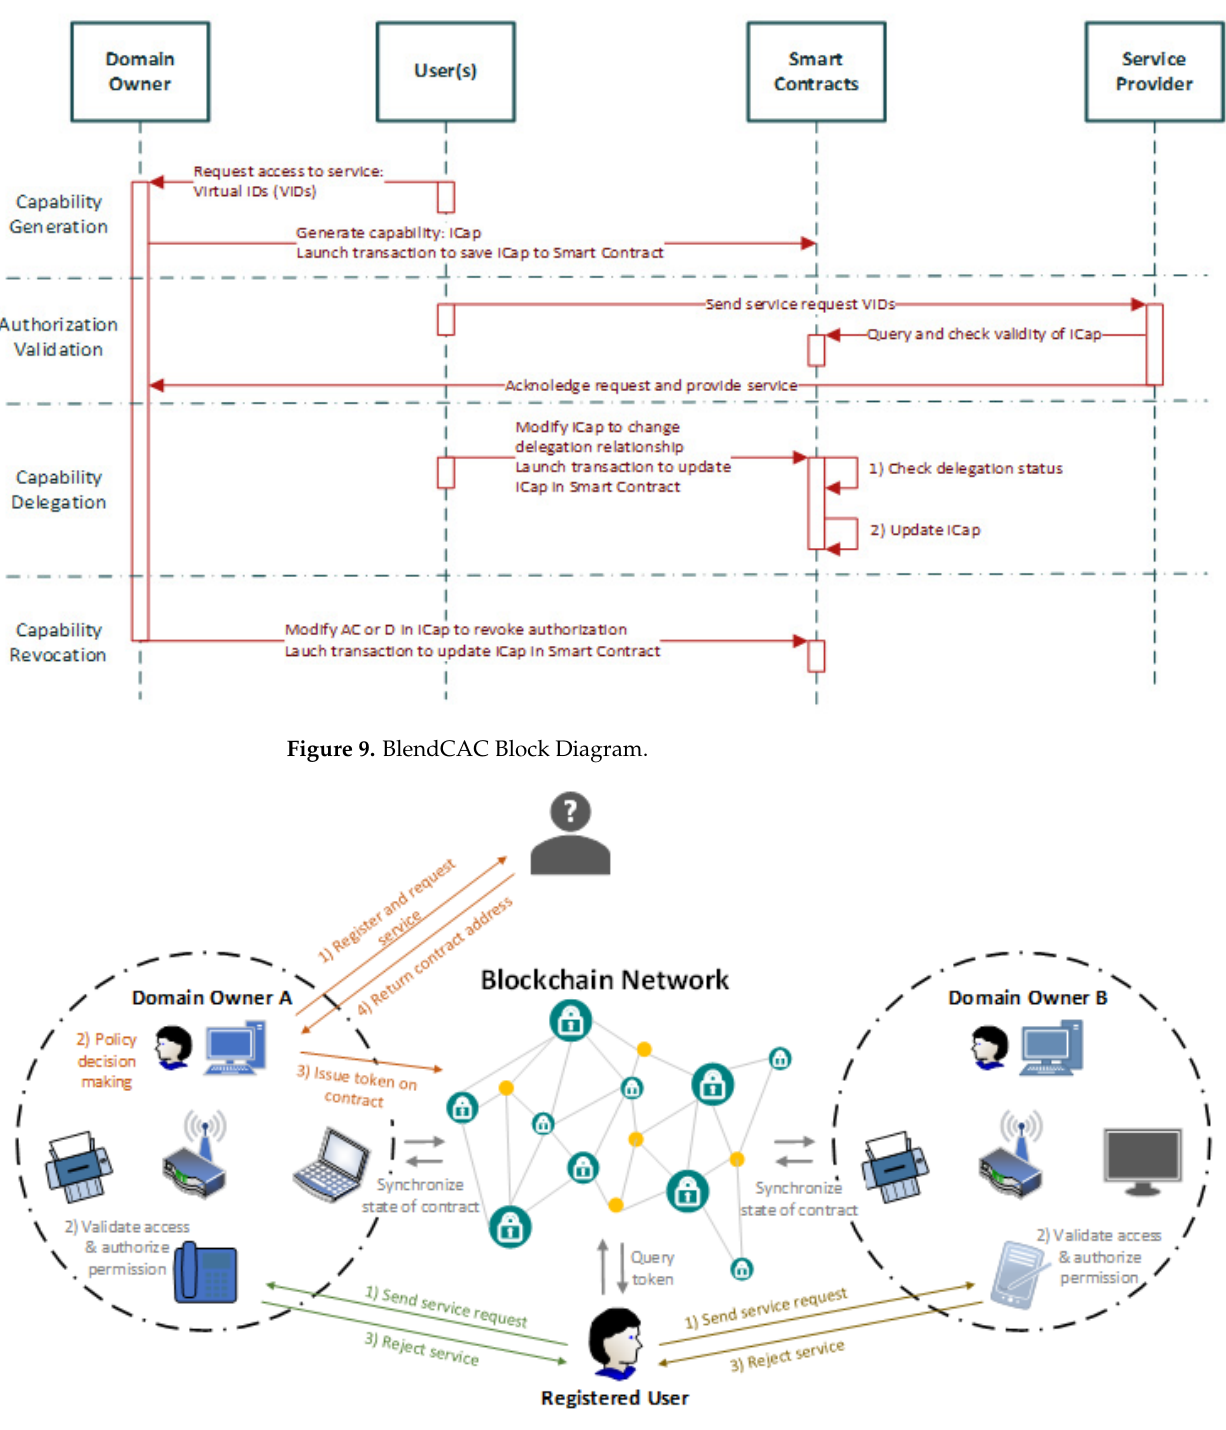
Figure 10. BlendCAC System Architecture.